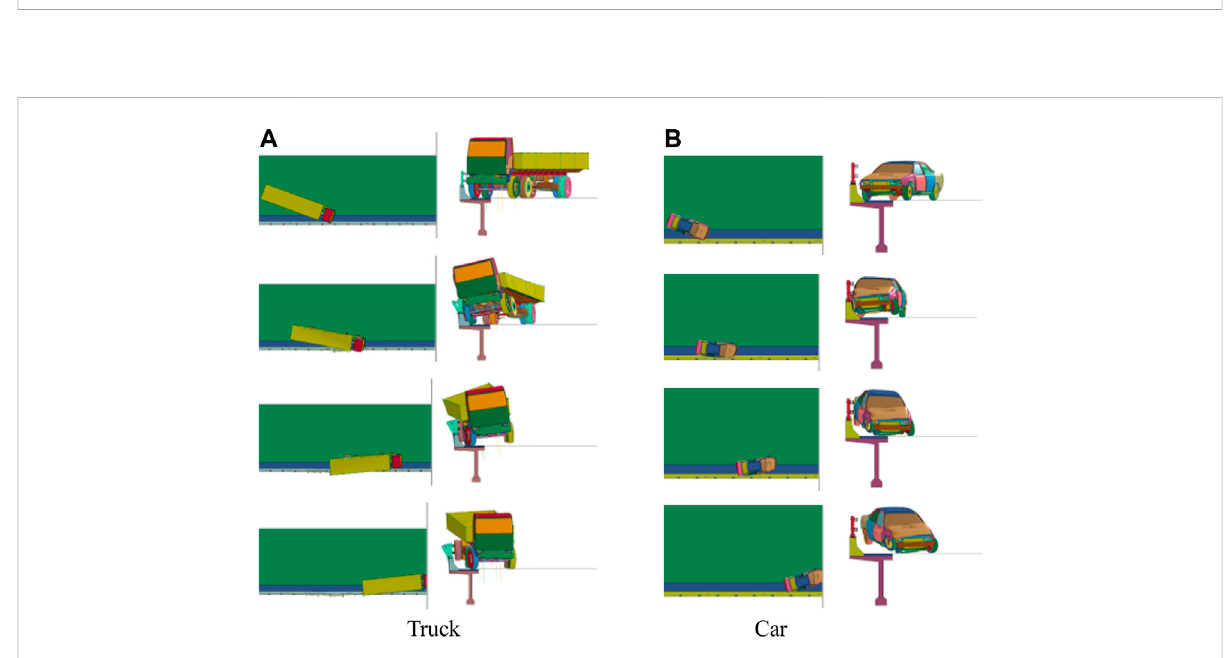
FIGURE 4 Driving process of the truck and car impacting the guardrail in scheme 3. (A) Truck. (B)